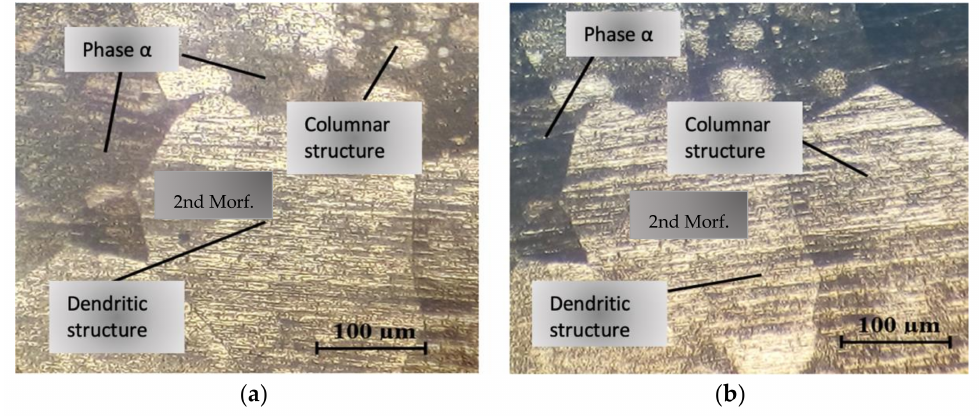
Figure 5. Heat affected zone micrography; ( a ) left side; ( b ) right